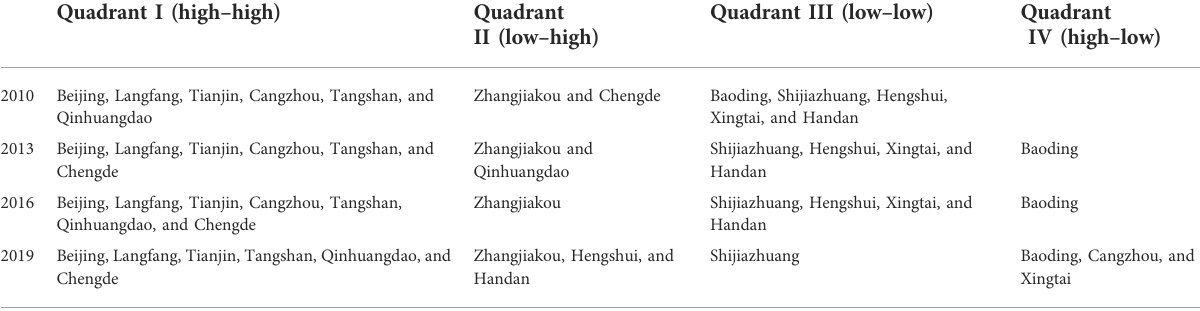
TABLE 2 The spatial distribution of tourism eco-ef fi ciency in the Beijing-Tianjin-Hebei region. Quadrant I (high –